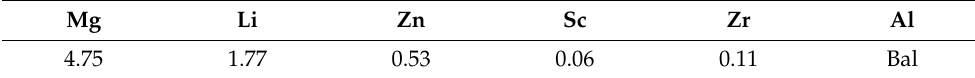
Table 1. Exact chemical composition of Al-Mg-Li alloy (wt. %).